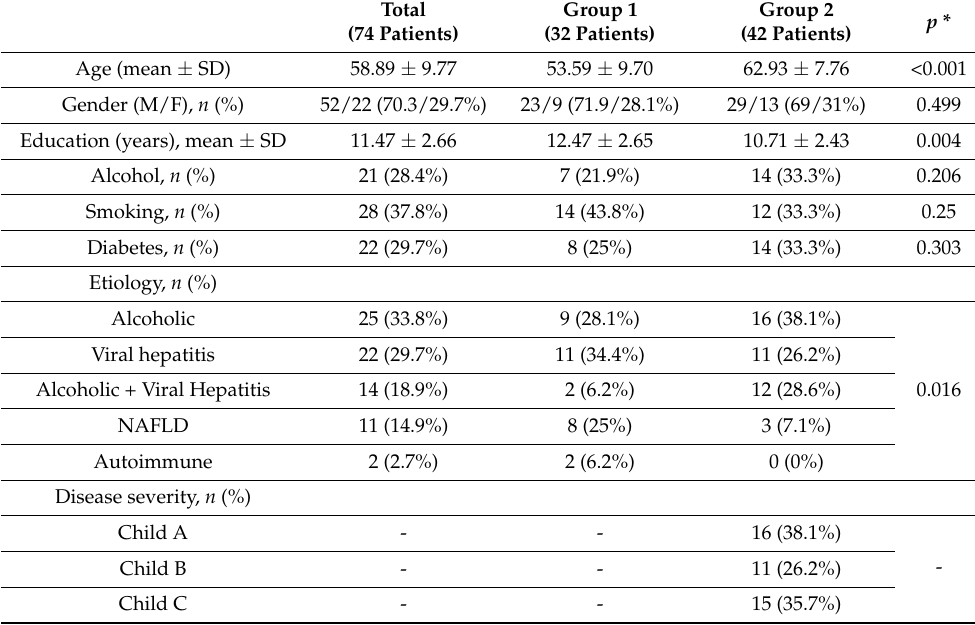
Table 1. Background characteristics of patients with CLDs enrolled in the